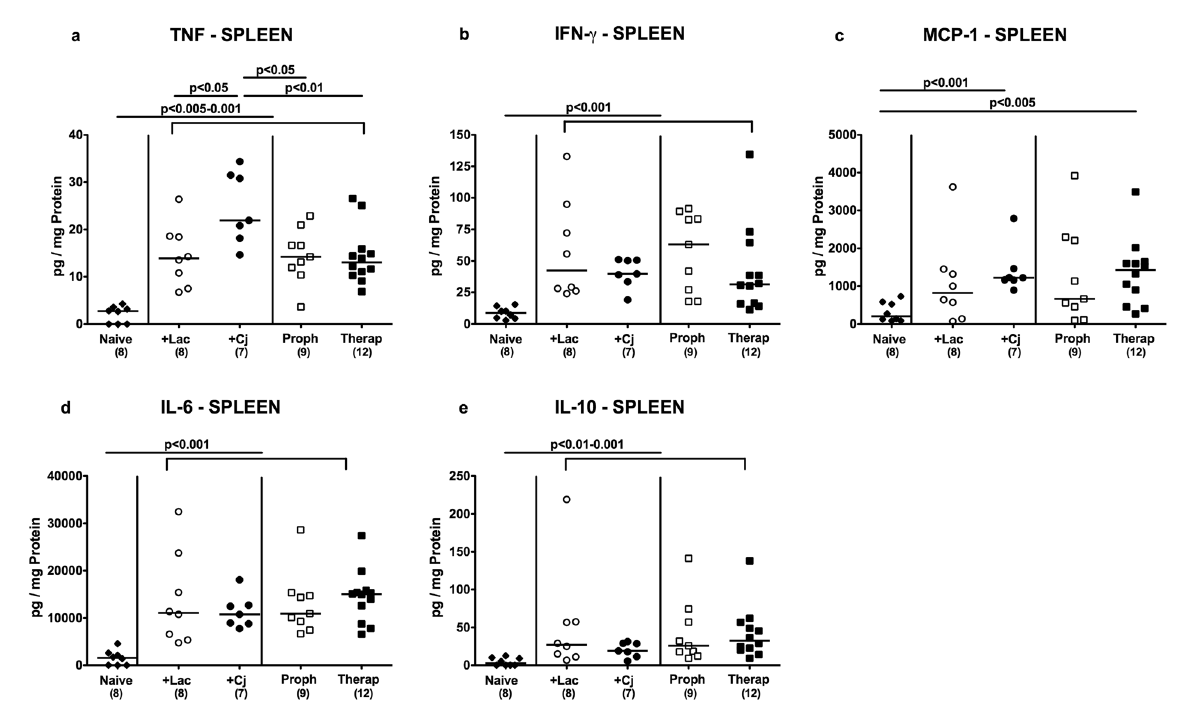
Figure 7. Splenic secretion of pro- and anti-inflammatory mediators of C . jejuni strain 81–176 and/or L . johnsonii reassociated secondary abiotic mice. Secondary abiotic mice were perorally infected with C . jejuni strain 81–176 (Cj) and associated with L . johnsonii (Lac) either 14 days before (prophylactic regimen, Proph; white squares) or 7 days thereafter (therapeutic regimen, Therap; black squares) and compared to mono- associated mice ( + Lac, white circles; + Cj, black circles). ( a ) TNF, ( b ) INF- γ , ( c ) MCP-1, ( d ) IL-6, and ( e ) IL-10 concentrations were determined in ex vivo biopsies derived from spleens at days 21 or 28 following initial C . jejuni or L . johnsonii infection, respectively. Naive (N) mice (black diamonds) served as uninfected controls. Medians (black bars), levels of significance (p-value) determined by one-way ANOVA test followed by Tukey post-correction test for multiple comparisons and numbers of analyzed animals (in parentheses) are indicated. Data were pooled from three independent